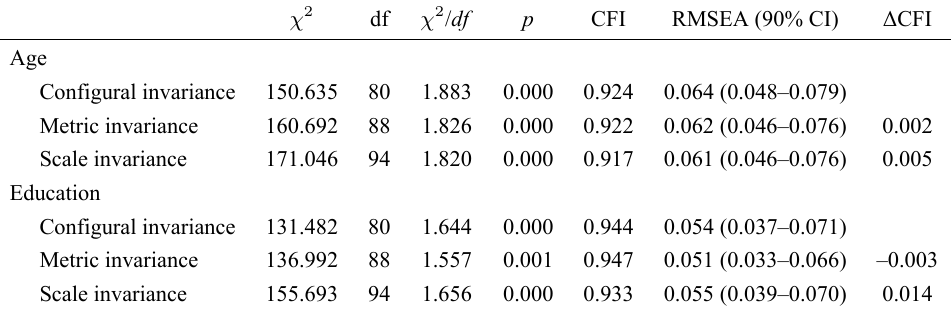
Table 5. Measurement invariance tests of the C19TSS across age and